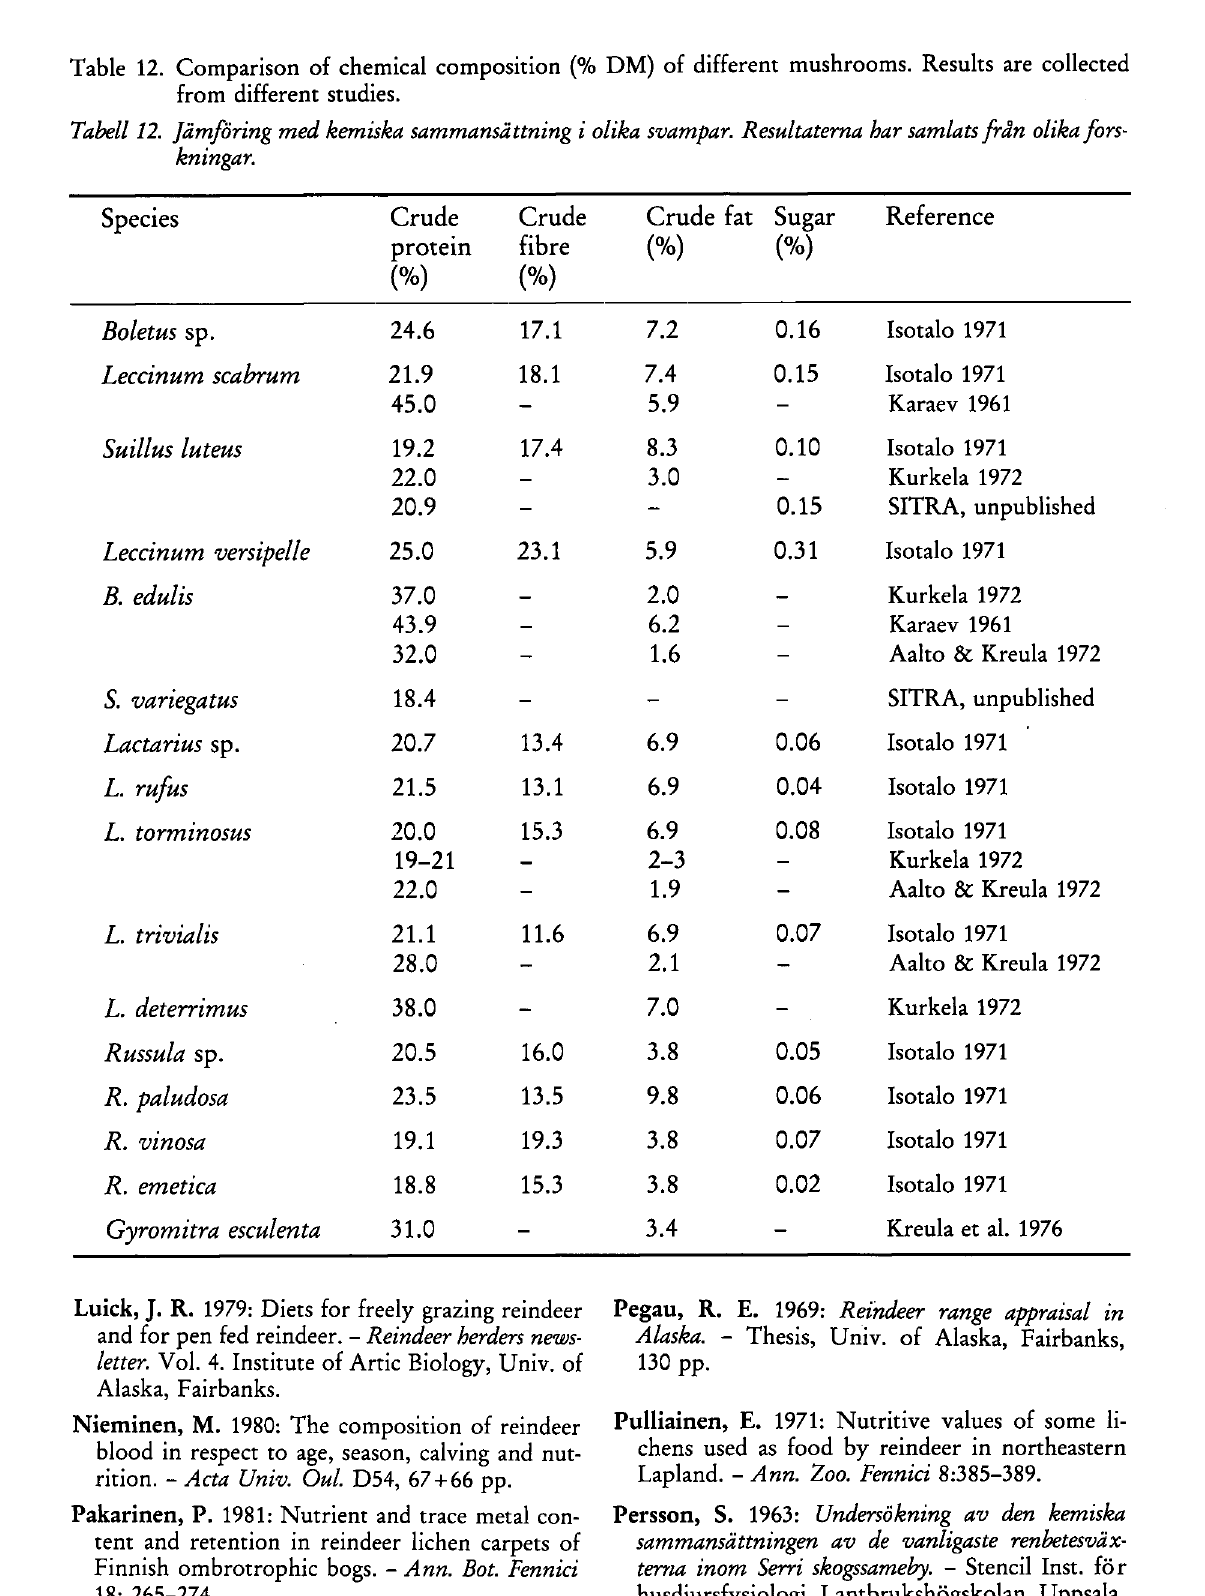
Table 12. Comparison of chemical composition (% DM) of different mushrooms. Results are collected from different